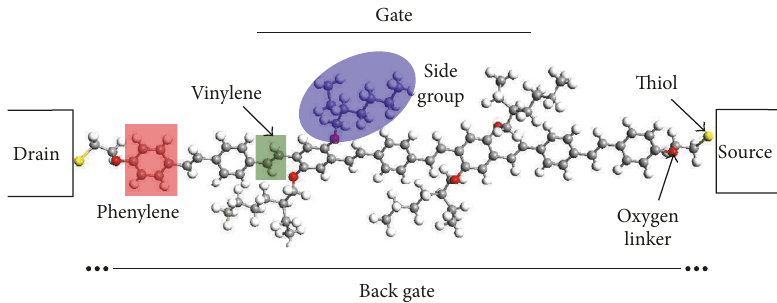
Figure 2: The structure of the device with different parts of molecule